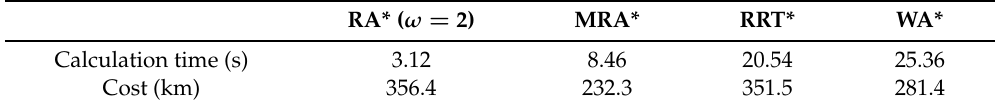
Table 6. Comparison with different